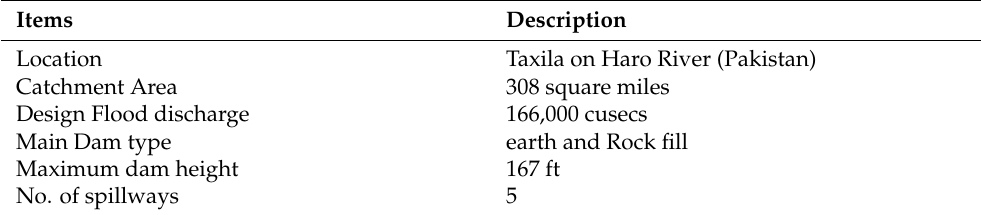
Table 2. General Features of Khanpur Dam.